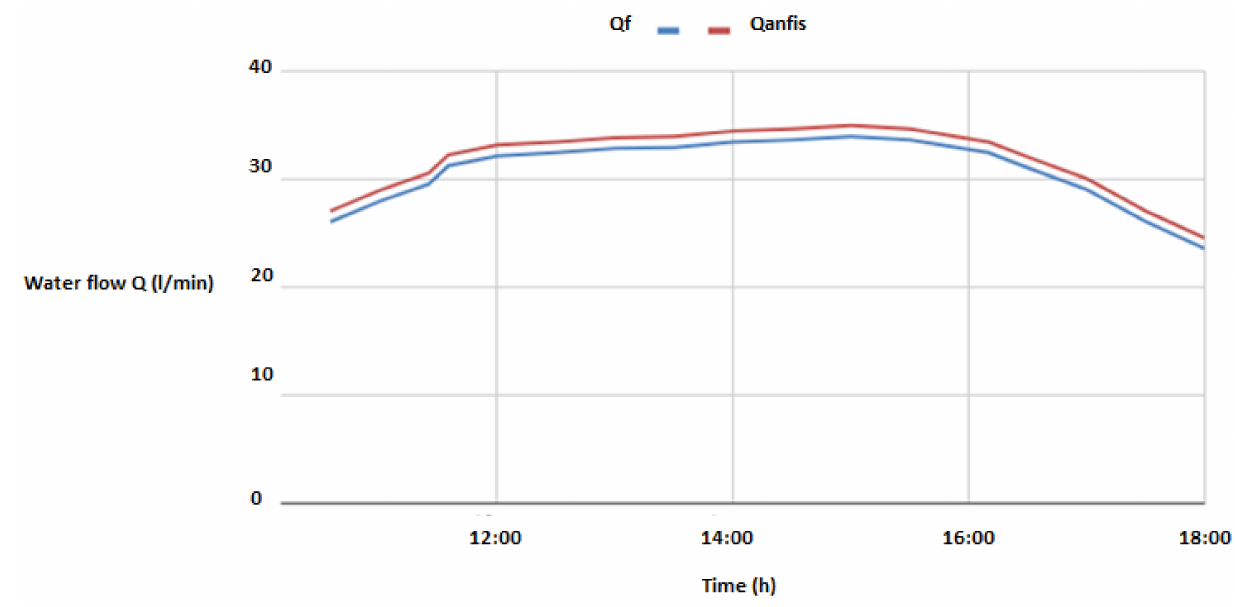
Figure 24. Flow rate characteristics (L/min).